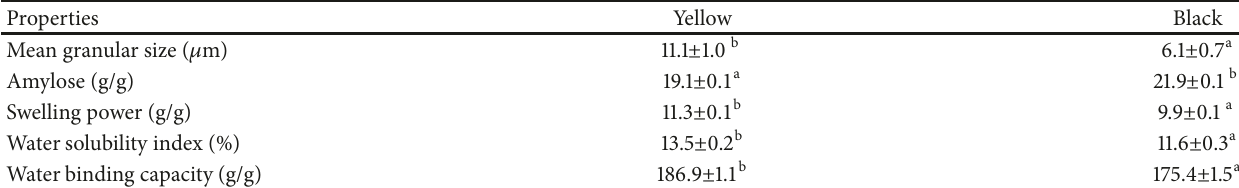
Figure 1: SEM images of starch granules isolated from yellow (a) and black (b) tigernuts. Table 1: Physicochemical properties of starches from yellow and black tigernut cultivars.